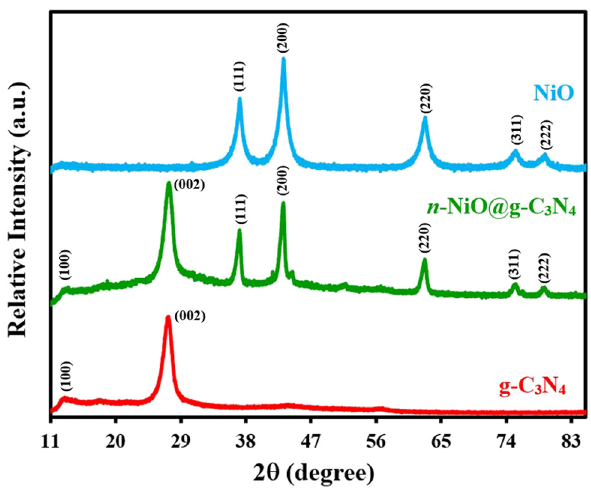
Figure 2: XRD of pure g - C 3 N 4 , pure NiO, and n - NiO@g - C 3 N 4